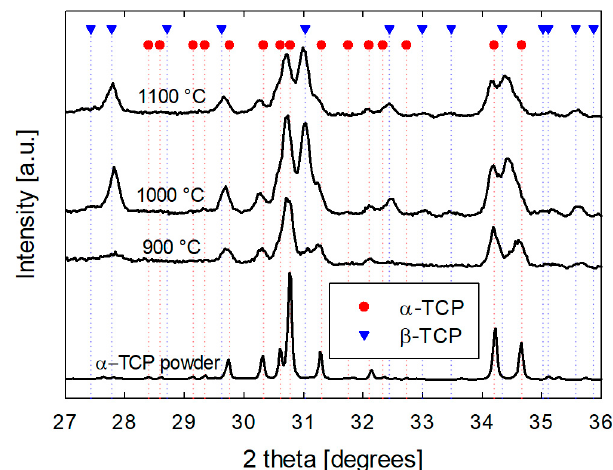
Figure 3. XRD patterns of the TCP–Fe composite sintered by spark plasma sintering at different temperatures and the starting α‐ TCP powder. The patterns are presented between 27 and 36 (2 ‐ theta degrees) to highlight the effect of the sintering temperature on the ratio between α‐ and β‐ tricalcium phosphate polymorphs.